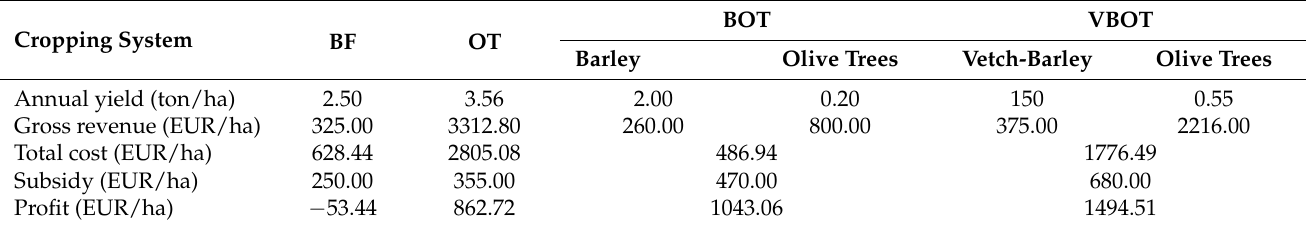
Table 3. Economic data for the four cropping systems.